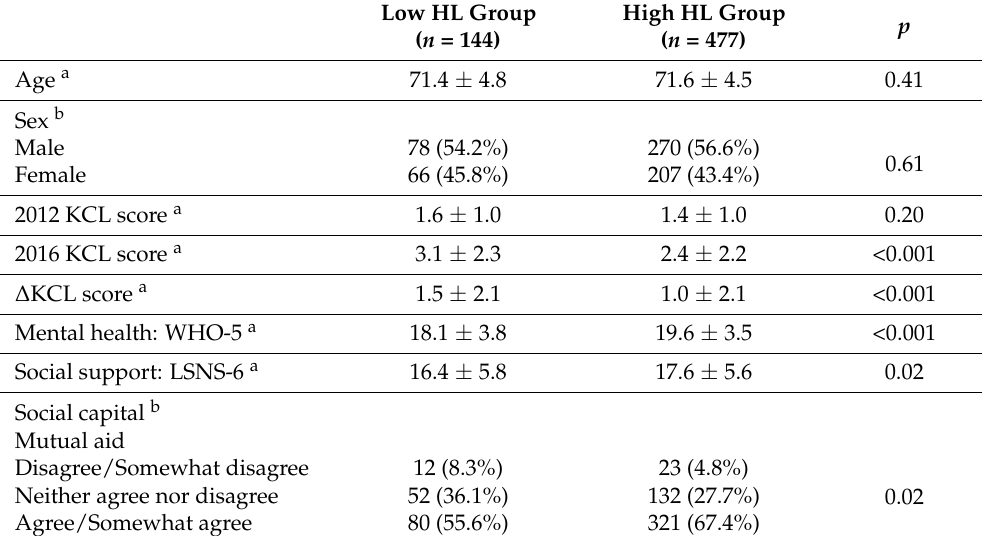
Table 2. Factors influencing the progression of frailty by health